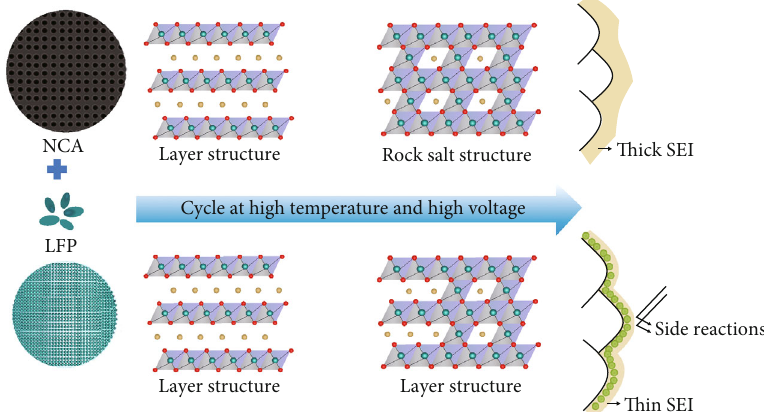
Figure 3: A scheme illustrating the e ff ects of a lithium iron phosphate coating on NCA cathodes